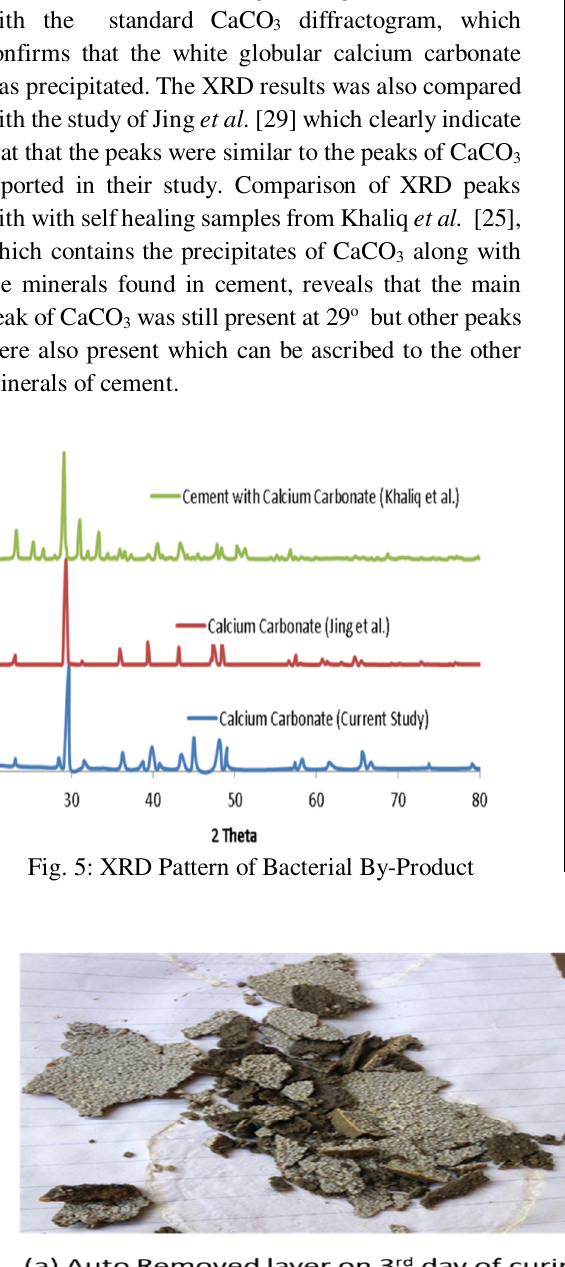
Fig. 7: Third and Fourth Day of